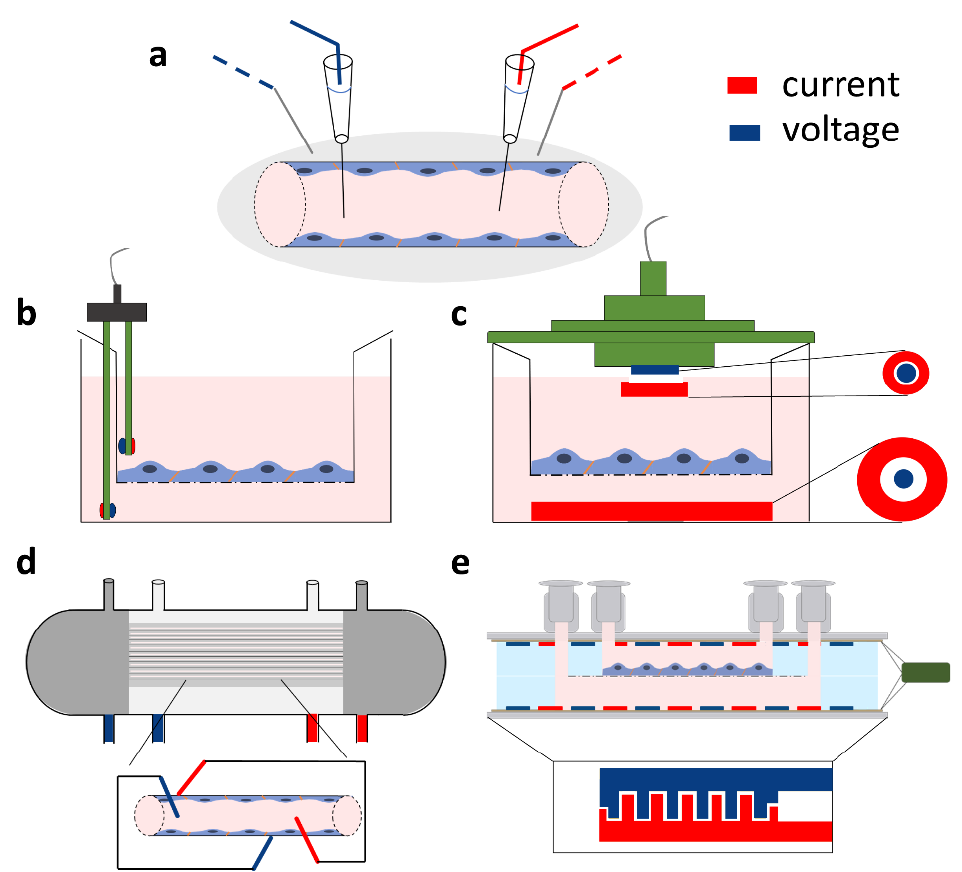
Figure 2. Direct current or quasi-direct current methods for in vivo and in vitro transcellular electrical resistance and impedance measurements. All types of setups include a four-point measurement method based on two current electrodes (red) and two voltage electrodes (blue). ( a ) Setup for electrical resistance registration of brain surface microvessels. ( b ) Chopstick and ( c ) chamber silver/silver chloride (Ag/AgCl) electrode arrangement for the measurement of transcellular resistance across cellular monolayers cultured on different sizes of cell culture inserts. ( d ) Impedance measurement setup on a hollow-fiber cartridge model. ( e ) Resistance measurement on a novel lab-on-a-chip model based on electrodes prepared with gold sputter coating (method described in [14]).